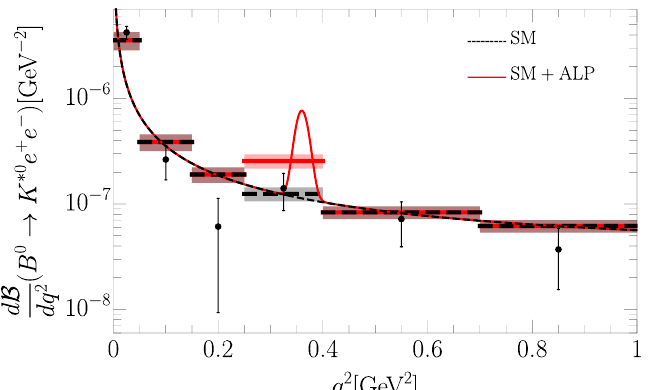
Figure 16. The experimental limits on the differential branching ratio d B / d q 2 ( B → K ∗ e + e − ) obtained from ref. [114], together with the SM (in black) and the NP (in red) predictions. Both the continuous and binned distributions, divided in the 6 measured bins of q 2 , are presented. For the NP, we have assumed an ALP with m = 0 . 6 GeV and decaying ≈ 100% into electrons. The quark a coupling is set to | ( c ) = 3 . 05 × 10 − 10 GeV − 1 d − c Q sb | /f a